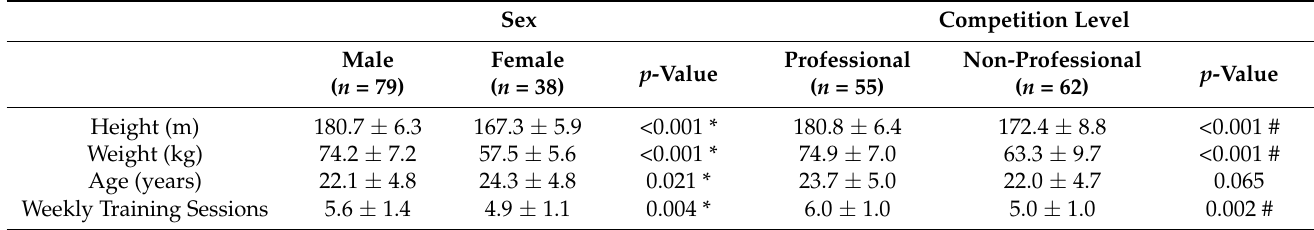
Table 1. Characteristics of the sample according to sex and competitive